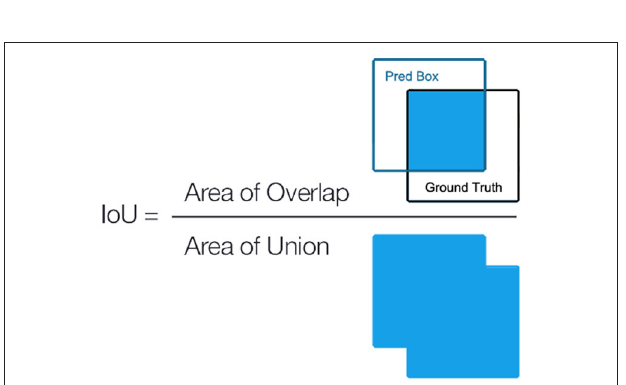
FIGURE 9 | The ShuffleNet v2 backbone. Each line describes a sequence of one or more identical (modulo stride) layers, repeating for n times. All layers in the same sequence have the same number c of output channels. The first layer of each sequence has a stride s and all others use stride 1. All spatial convolutions use 3 × 3 kernels.